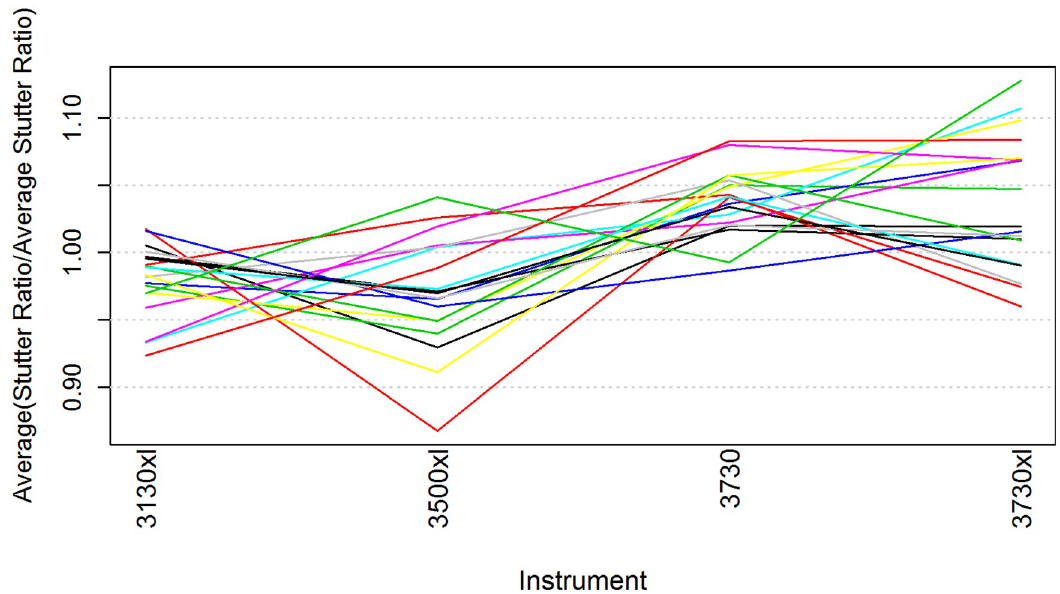
Fig 3. Summary of the effect of instrument on stutter ratio across markers. The combination across the 19 STR markers and relative position for each of the instruments is condensed into a single plot. Each line corresponds to a particular marker, where the four points on each line denote the respective average normalized stutter ratios within that STR marker for the four instruments.